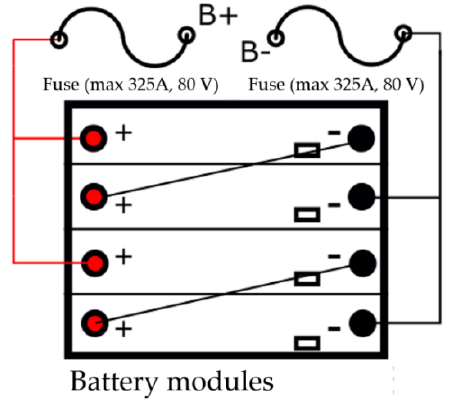
Figure 5. The connection topology of the four battery modules.